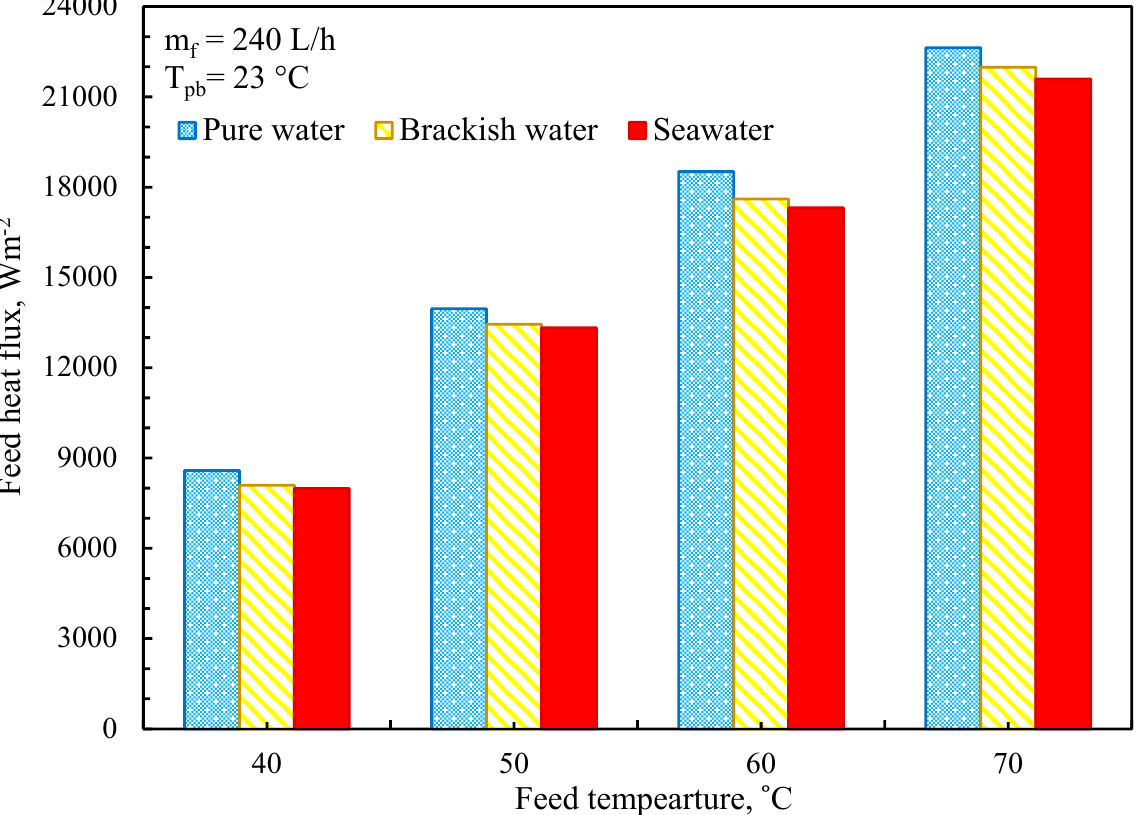
◦ f = 240 L/min, T pb = 23